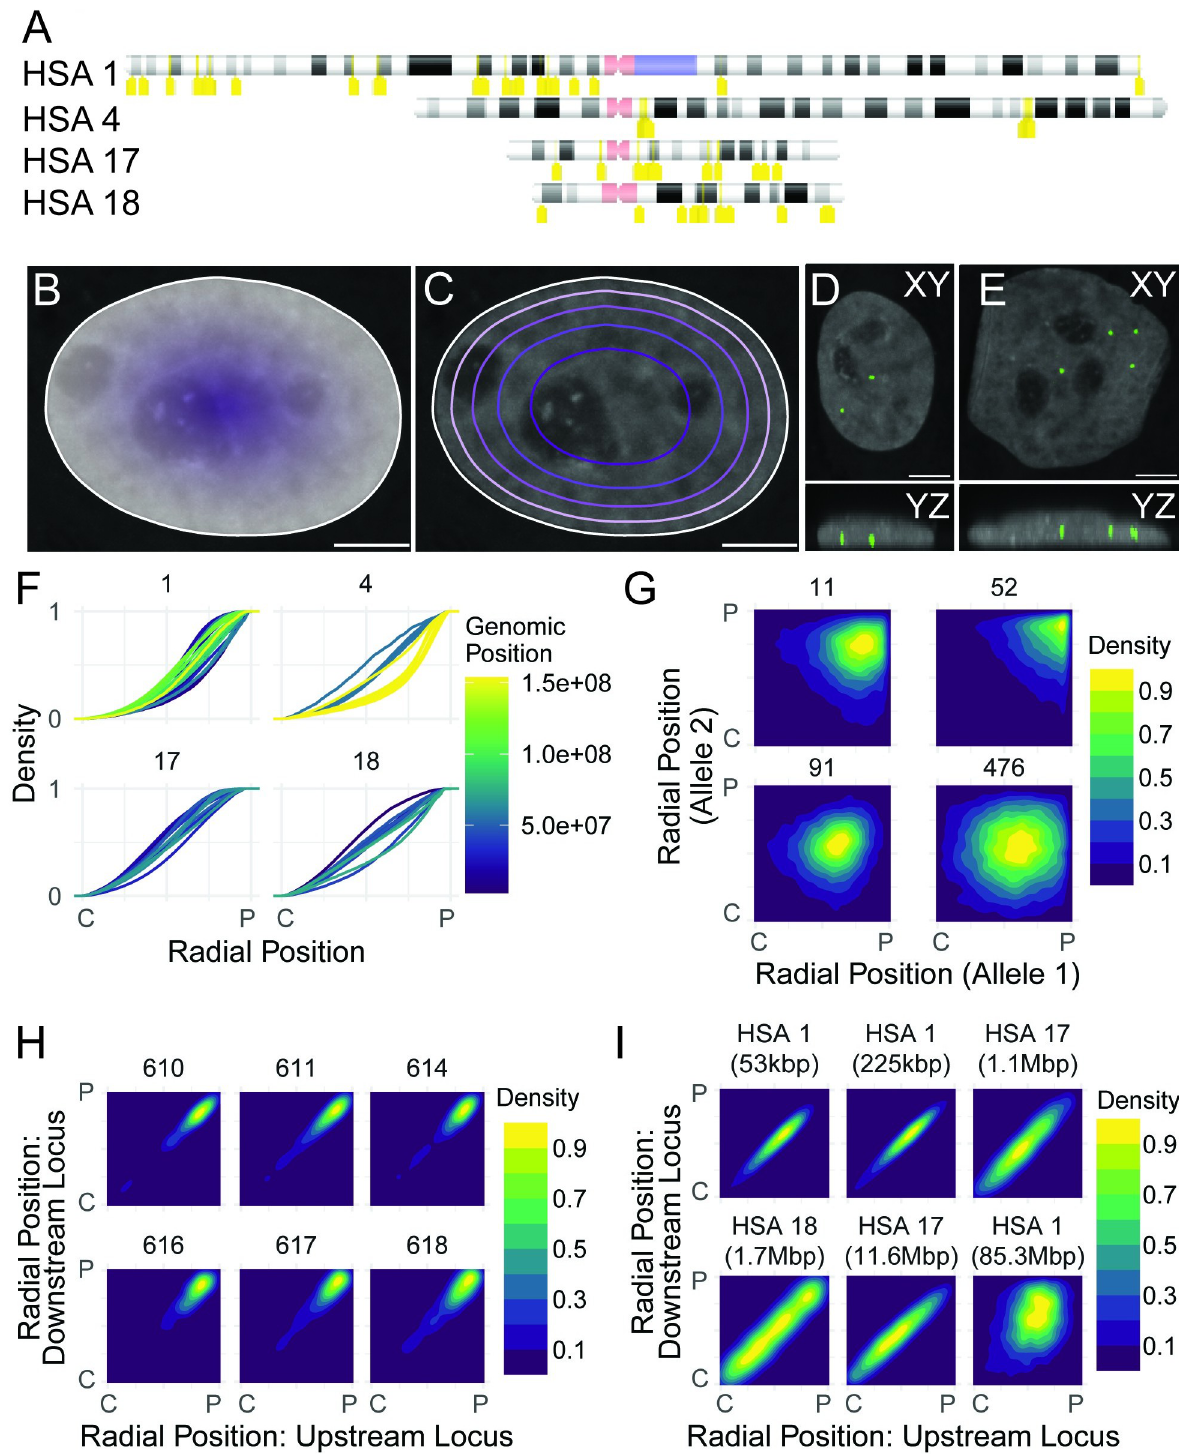
Fig 1. Determination of radial position of genome regions. A: Schematic location of genome probes used. Probes are indicted in yellow; centromeres in pink, pericentromeric regions in purple. B: Diagram of normalized Euclidean distance transform for continuous radial position, showing the calculation of a radial position for every position within the nucleus. Dark, central: 0. Light, peripheral: 1. Scale bar: 5 μ m. C: Diagram of equi-area concentric shell boundaries for one nucleus. Note that equi-area shells have square-root spacing relative to radial position itself. Scale bar: 5 μ m. D: Maximum projections in XY (top) and YZ (bottom) showing a cell with a “false central” spot that appears central in XY but is likely